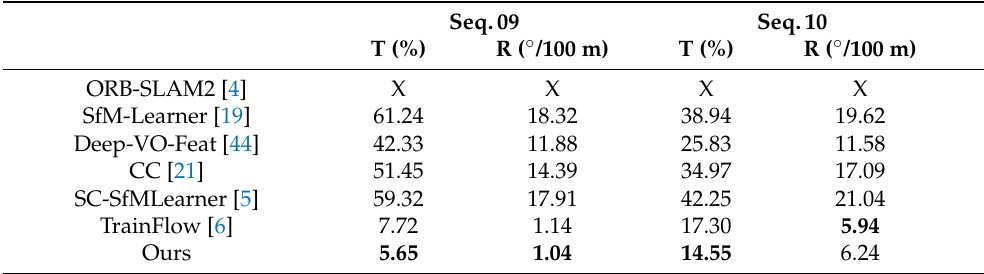
our method produced fairly good camera pose prediction in the large-amplitude-motion scene (stride =